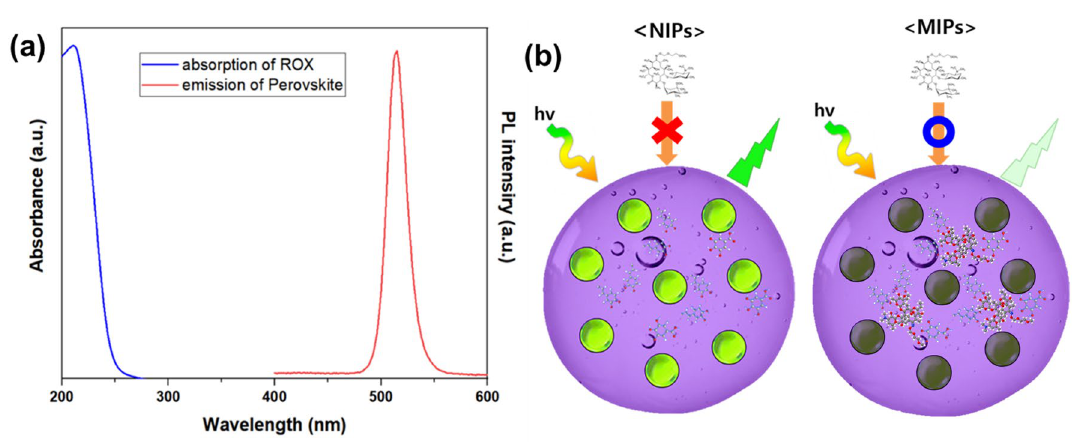
Figure 6. ( a ) PL and UV spectra of the emission of perovskite and absorption of ROX, ( b ) Schematic illustration of the proposed quenching mechanism of MIP/CsPbBr 3 during the exposure to